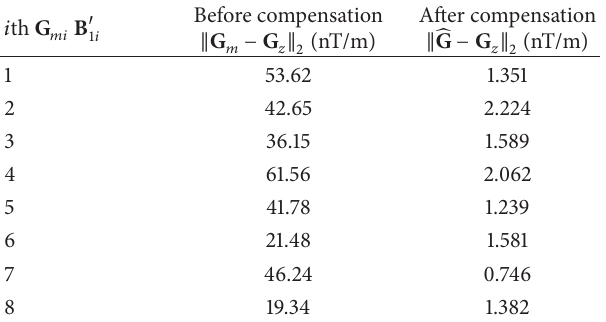
Table 1: The results of magnetic interference compensation simula-